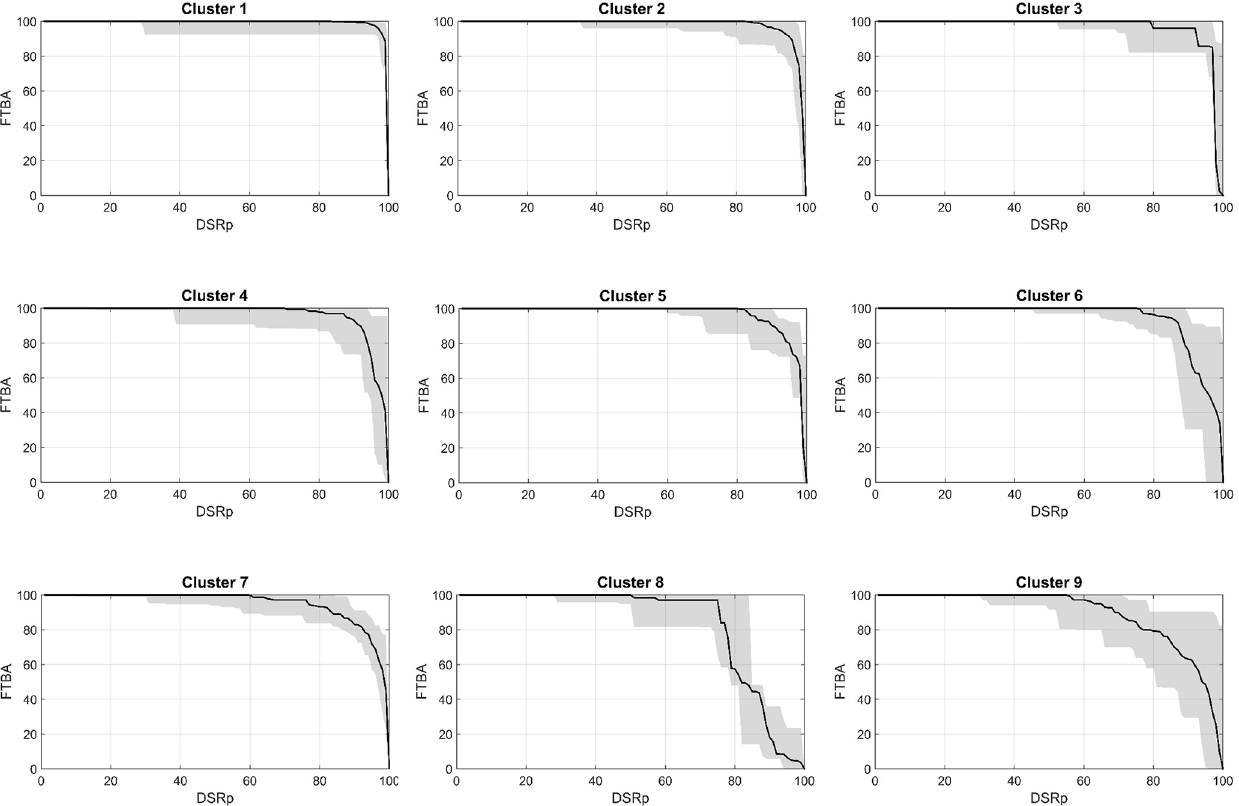
Figure 8. Fraction of total burnt area (FTBA) vs DSR percentile (DSRp) for the municipalities of each of the nine clusters. The black line is the median of all curves in each cluster. The shaded area is defined by the maximum and minimum curves in each